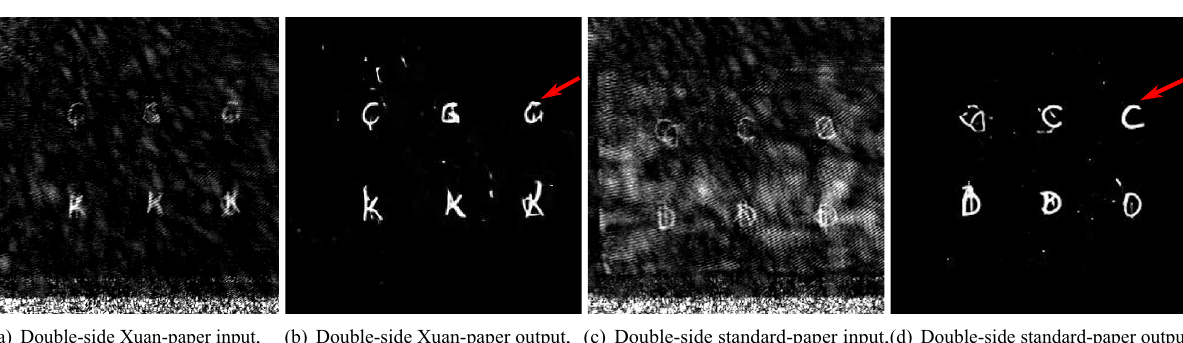
Figure 7. Two exemplary results of Pix2pixGAN on the real THz image written on two-side of the Xuan paper and standard paper,